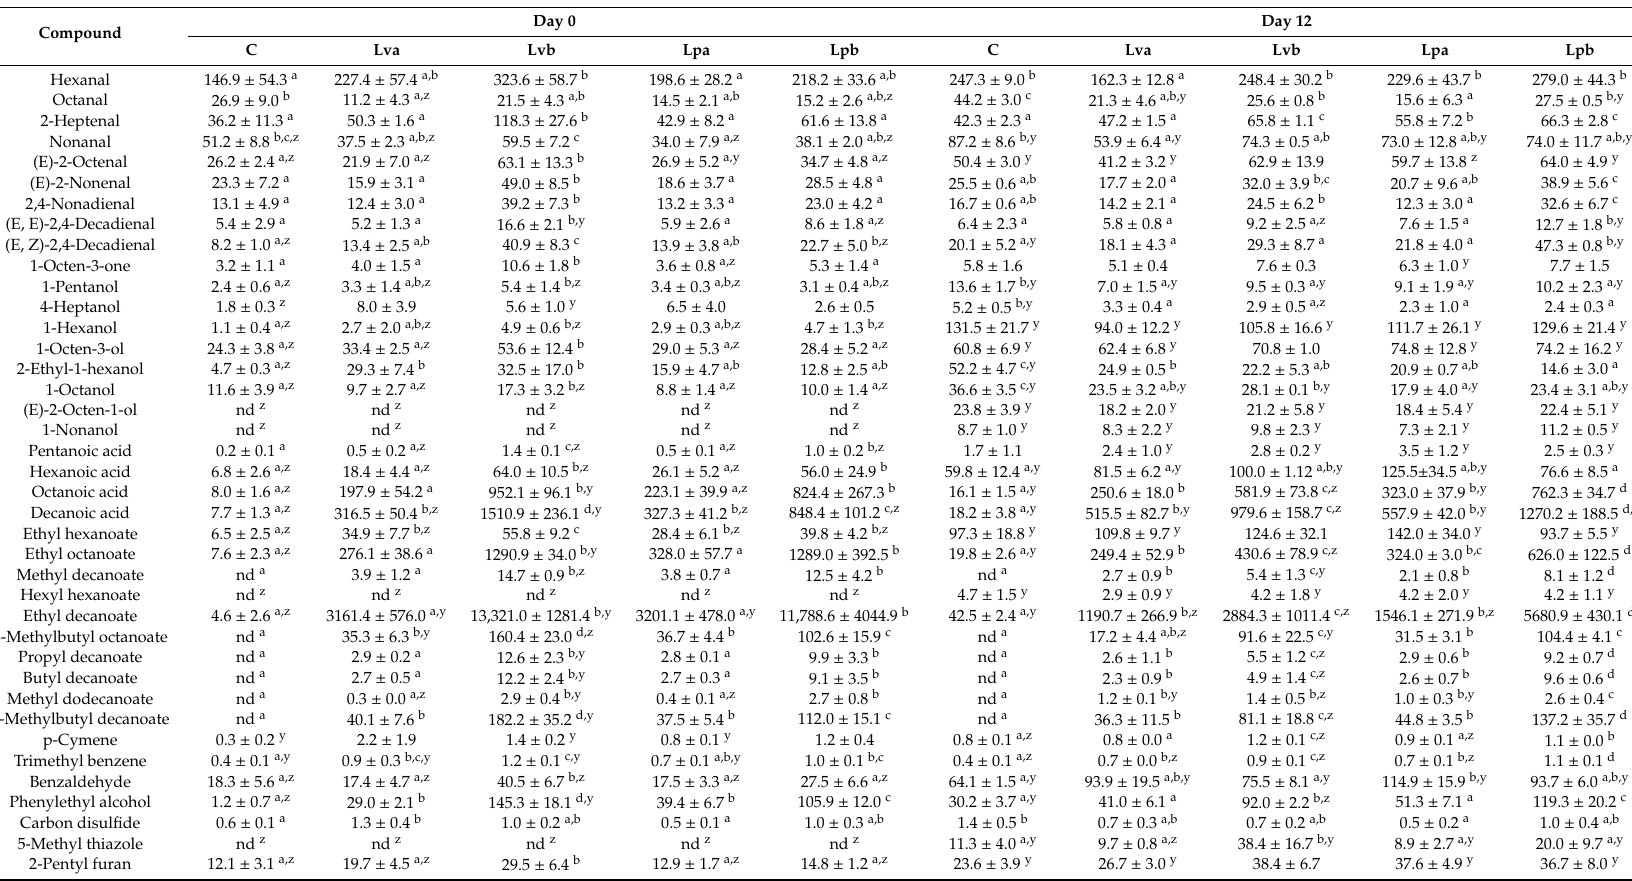
Table 4. Concentration (mean ± standard deviation) of the most relevant volatile compounds (ng / g DM ) in deer burgers at 0 and 12 days of chilled storage.